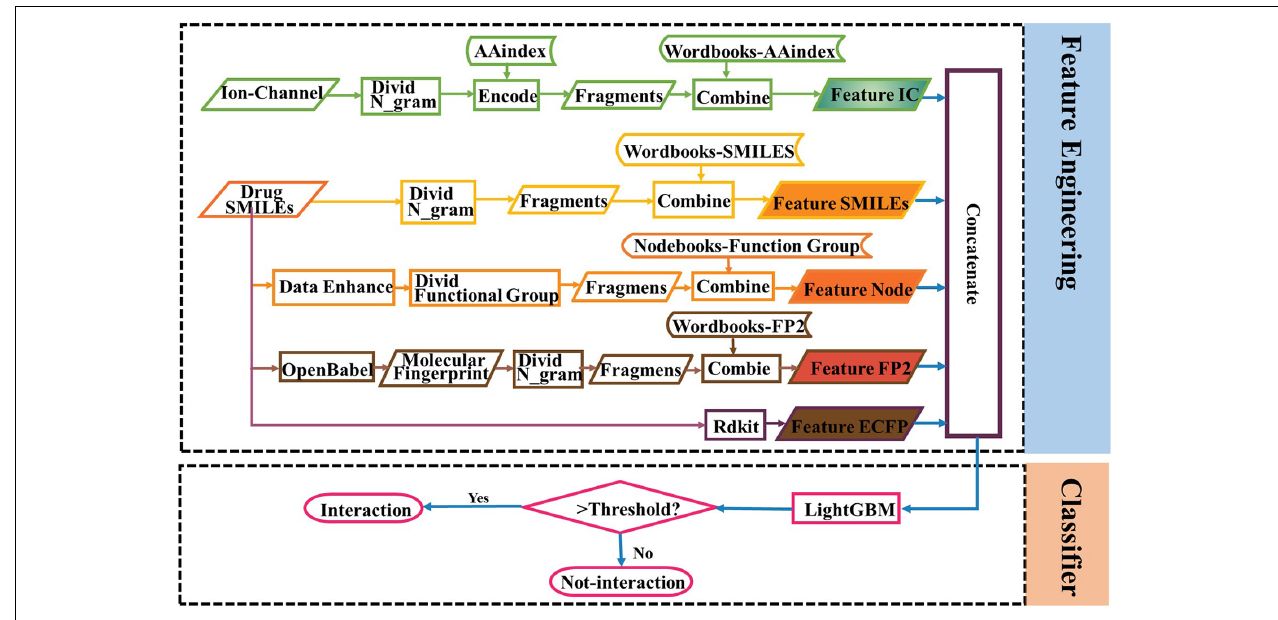
FIGURE 8 | Flowchart of the iCDI-W2vCom